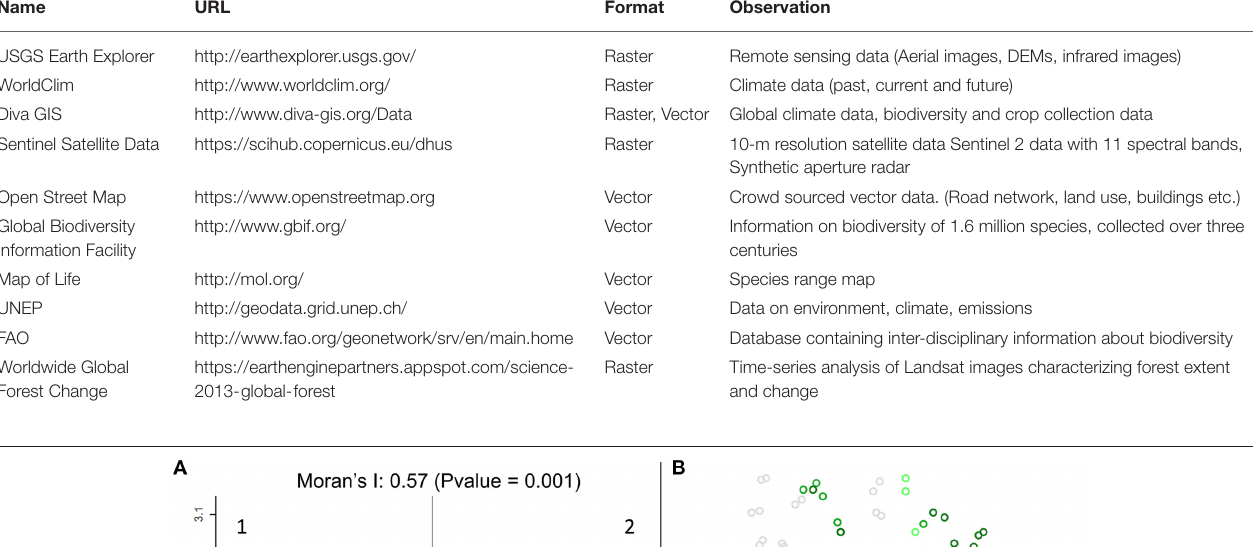
TABLE 1 | Ten main public sources of environmental data (URLs: consulted on June 10, 2016).